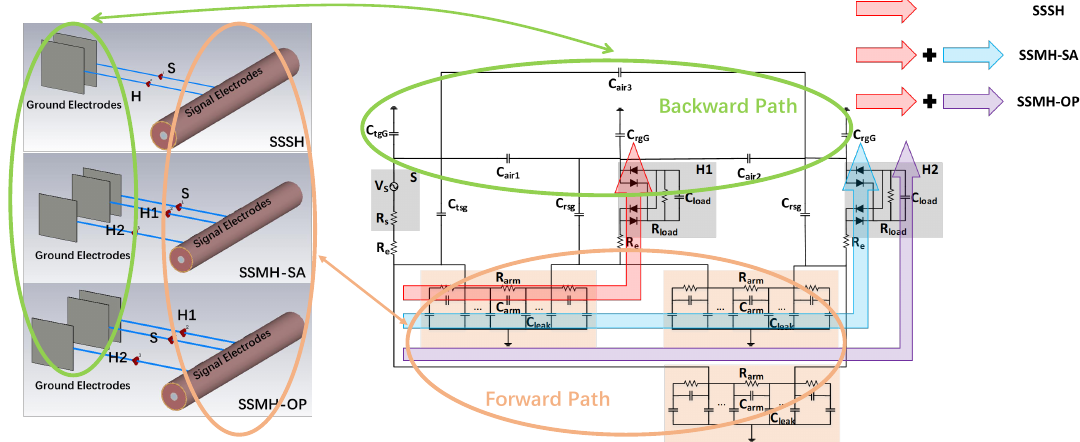
Figure 14. Proposed empirical circuit model and its relationship with the S-parameter model in